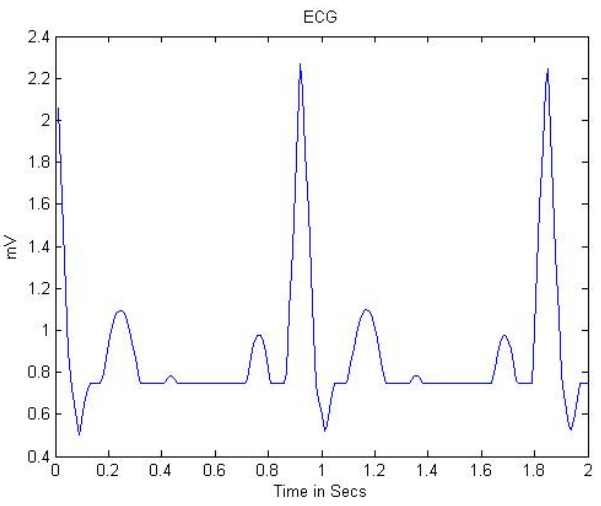
Figure 9. Sample ECG signal.